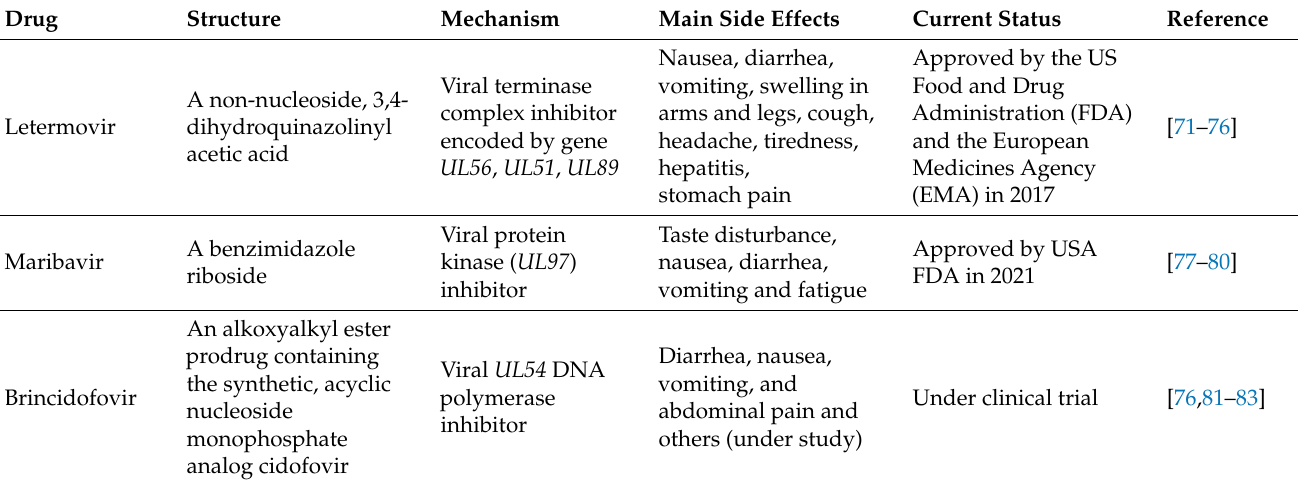
Table 3. Novel drugs have been approved or being developed for the treatment of HCMV